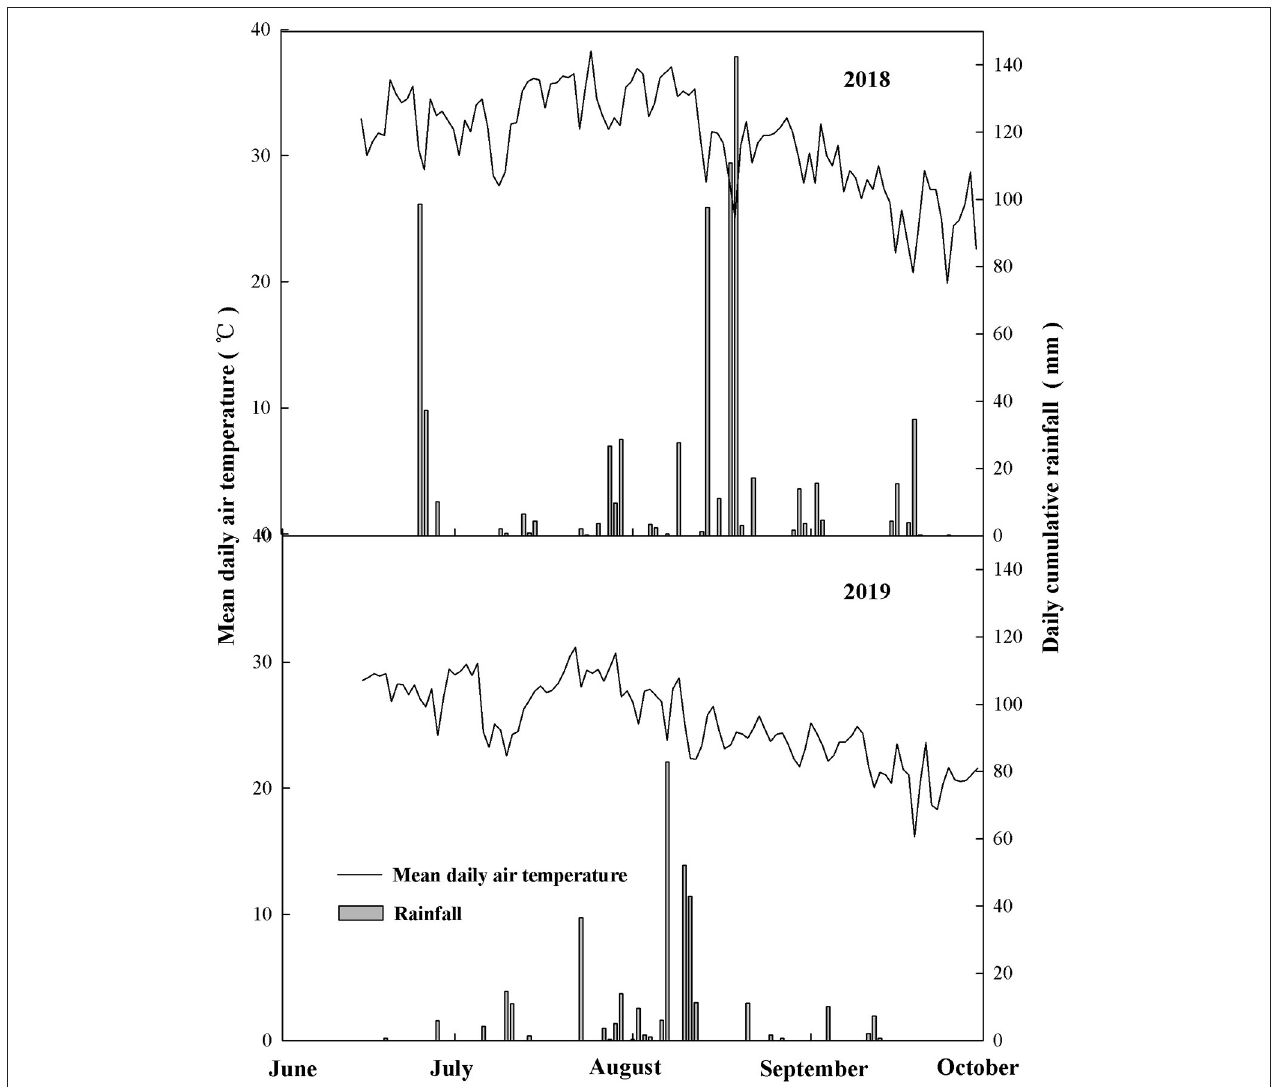
FIGURE 1 | Weather conditions during maize season (from June to October) in 2018 and